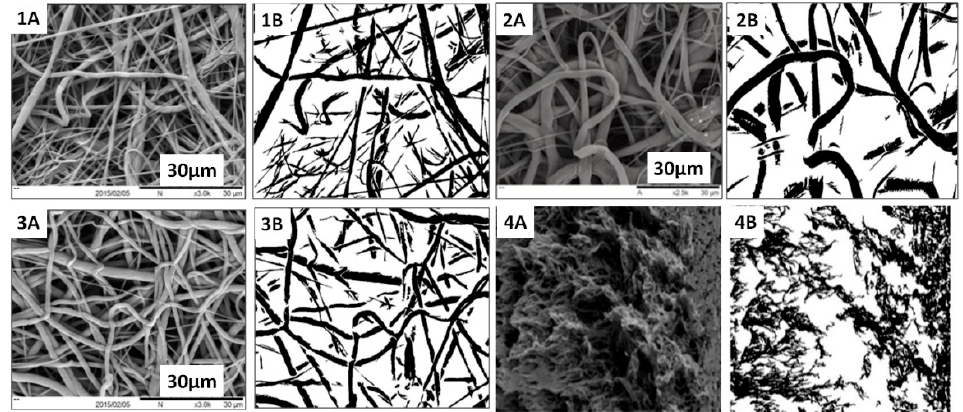
Figure 8. Typical original and black and white SEM images for ( 1A , 1B ) sample 1, ( 2A , 2B ) sample 2, ( 3A , 3B ) sample 3 and ( 4A , 4B ) polyvinlyidene fluoride (PVDF) membrane (commercial membrane).